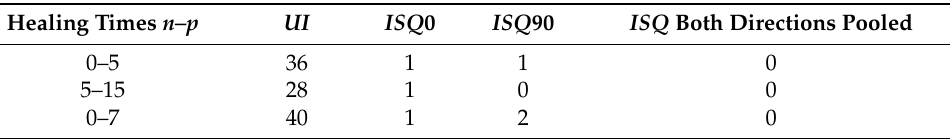
Table 5. Number of implants for which the estimation of healing time is minimal for the corresponding indicator and the corresponding healing